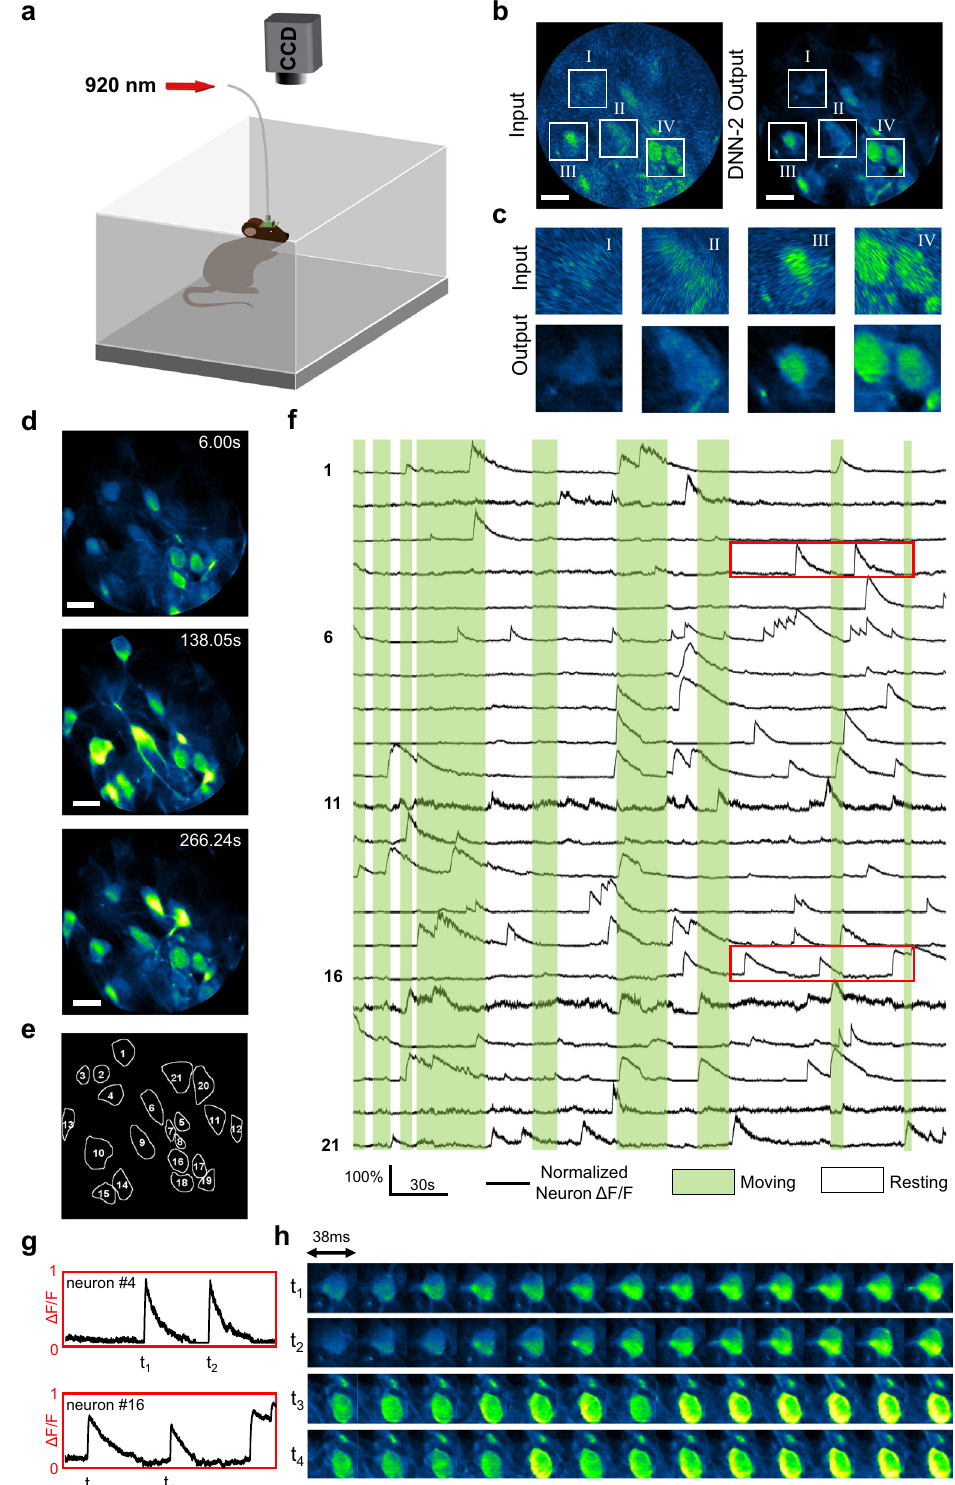
Fig. 4 Application of the trained DNN-2 to high-speed (26 fps) 2P fi berscopy brain imaging in freely behaving mice. a Imaging setup schematic of freely behaving mice. b Representative high-speed in vivo 2P images before (left, as input) and after (right, as output) DNN-2 enhancement. c Comparison between the DNN-2 input and output images for fi ne structures marked in the regions of interest (ROIs) I – IV in ( b ). d Representative dynamic images of neuron activities recorded at different time points. e Segmentation masks for the 21 neurons identi fi ed within the FOV obtained with the post-processing pipeline23. f Normalized calcium (GCaMP6m fl uorescence) signals along with behavior registration for the 21 neurons. g Zoomed-in temporal dynamics for two randomly selected time windows as marked in ( f ). h Spiking process of neurons corresponding to different time points shown in ( g ). Scale bars in ( b , d ): 20 µ